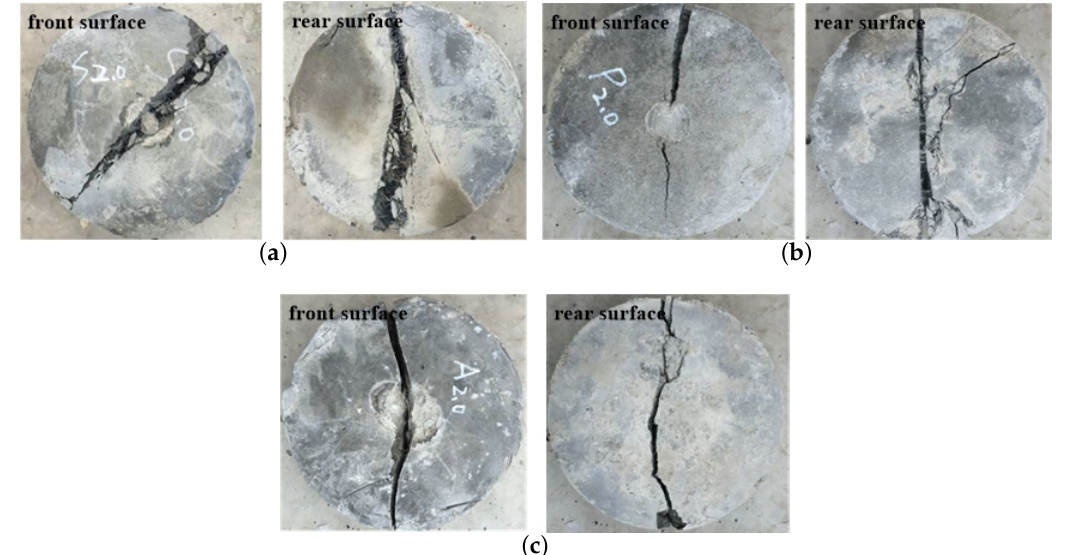
Figure 8. Failure patterns of the FRC specimens after drop weight test. ( a ) FRC with 2% SF; ( b ) FRC with 2% PP; ( c ) FRC with 2% PVA.